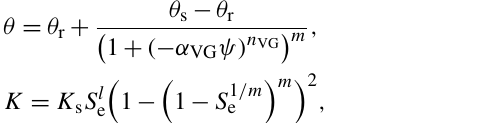
Figure 15. Heterogeneous soil. The effects of weight parameters λ i in the loss function on the performance of PINNs with respect to the relative squared error of the volumetric water content (cid:15) θ . (a) Upper layer. (b) Interface